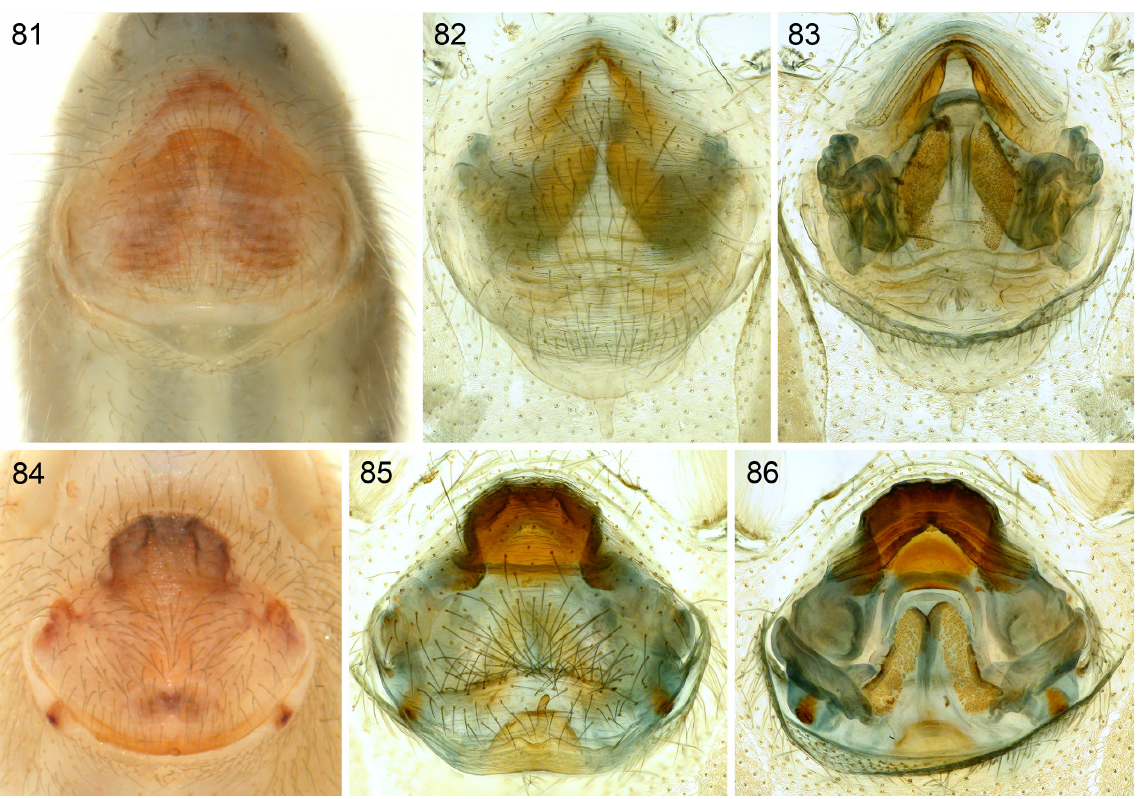
Figs 81–86. epigyna, ventral views, and cleared female genitalia, ventral and dorsal views. 81– 83 . Pholcus tanahrata Huber sp. nov. (ZFMK, Ar 15692). 84–86 . P. uludong Huber sp. nov. (ZFMK, Ar